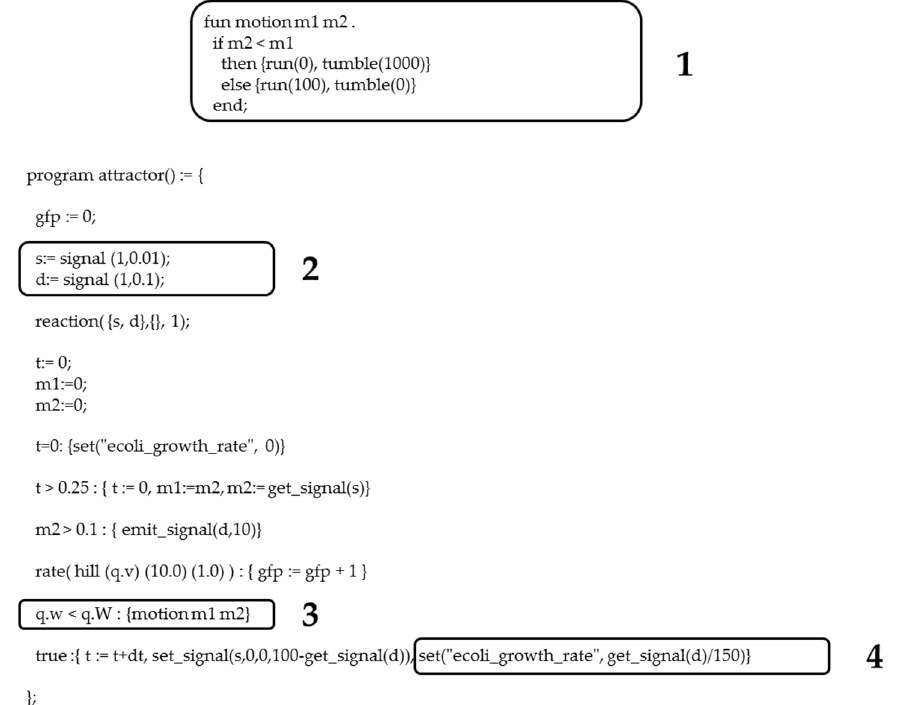
Figure A3. Chemotaxis selection routine implemented in Gro language for the 0/1 knapsack problem. ( 1 ) Code displaying the function that simulates the mechanism of bacterial chemotaxis. When the extracellular signal decreases, i.e., m2 < m1 in the Gro function, then CheY phosphorylation drops, resulting in erratic movement of the bacterium or tumble. Otherwise, if levels of extracellular substance increase, i.e., m2 > m1, then levels of CheY phosphorylation also rise, resulting in the bacterium effectively moving or running. ( 2 ) Command to declare the attractive extracellular substance(s) and its degradation (d). ( 3 ) Conditional sentence of bacterial chemotaxis. ( 4 ) Effect of the extracellular substance on bacterial growth rate.